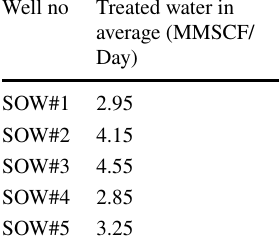
water in each shale oil well in MMSCF/Day during hydraulic